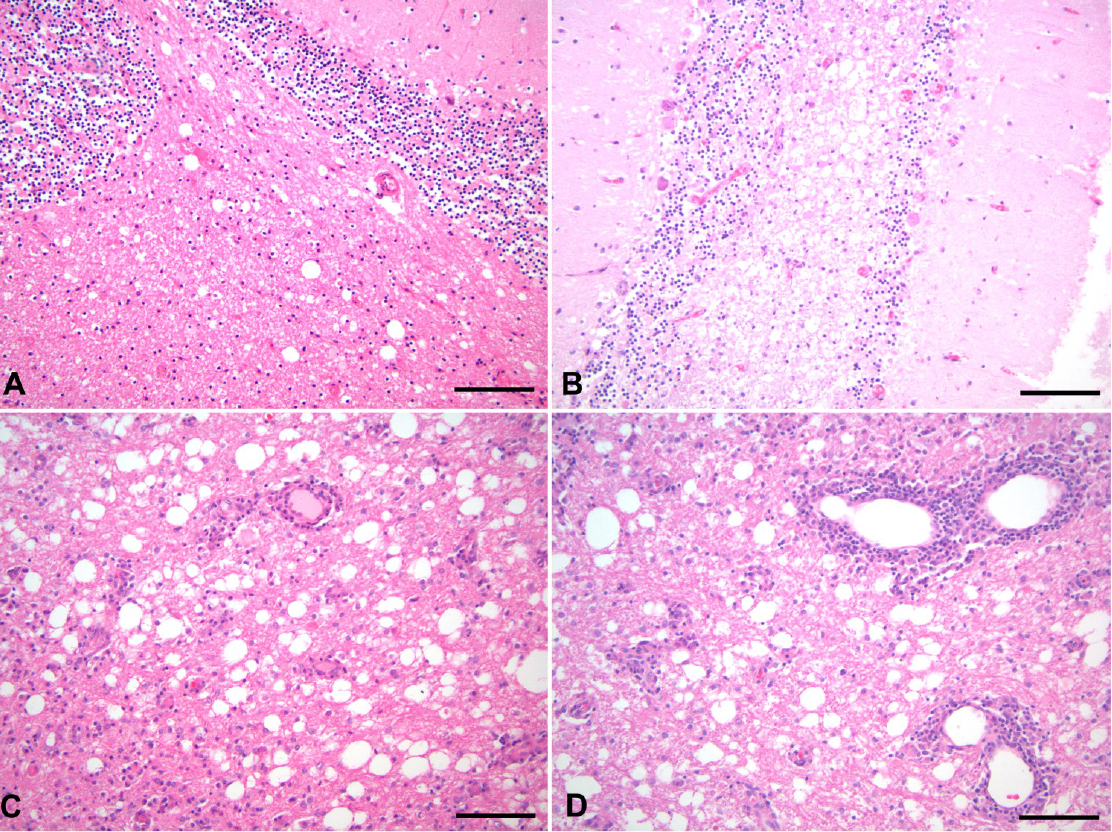
Figure 1. Histological lesions of CDV-DL in the time course of disease. ( A ) Acute lesions are characterized by vacuolization of the white matter due to myelin sheath edema. Inflammation is nearly lacking and restricted to a sparse intraparenchymal infiltration of T cells; ( B , C ) Progressive myelin loss (pallor and lack of eosinophilia) is present in subacute lesions. Subacute lesions are further divided into lesions without ( B ) and with ( C ) inflammatory cell infiltration; ( D ) Chronic lesions invariably display more than three layers of perivascular inflammatory cells, accompanying ongoing demyelination and axonal loss. Hematoxylin and eosin staining. Bars = 50